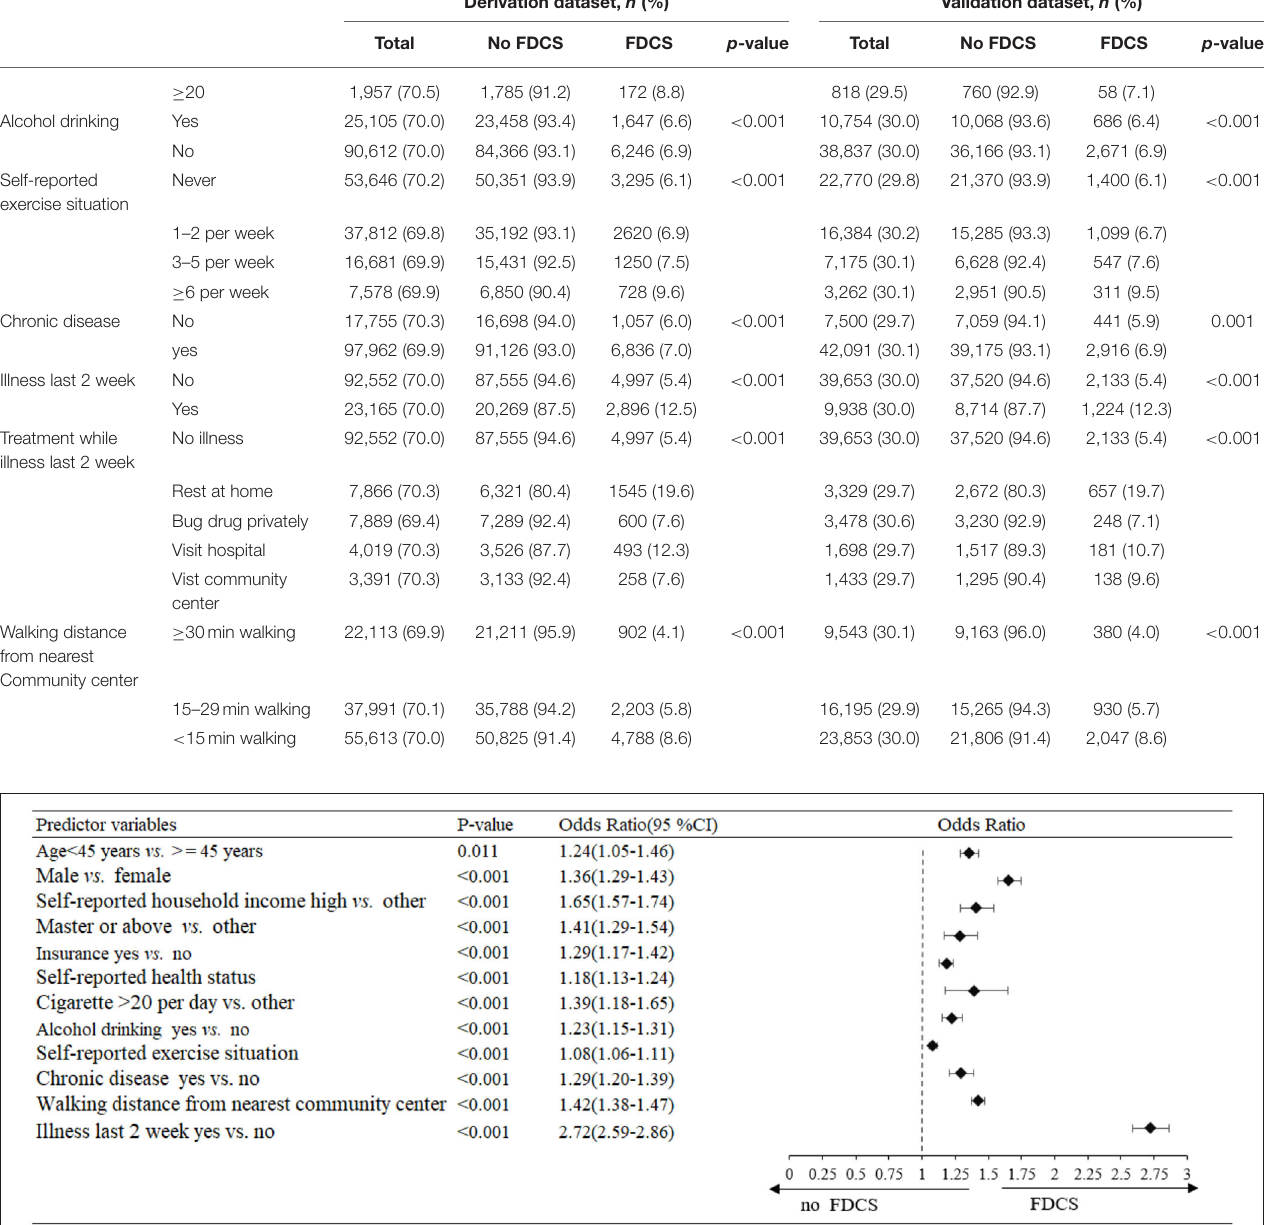
FIGURE 2 | Multivariable logistic regression analysis of predictors for the family doctor contract service (FDCS) in the development dataset.